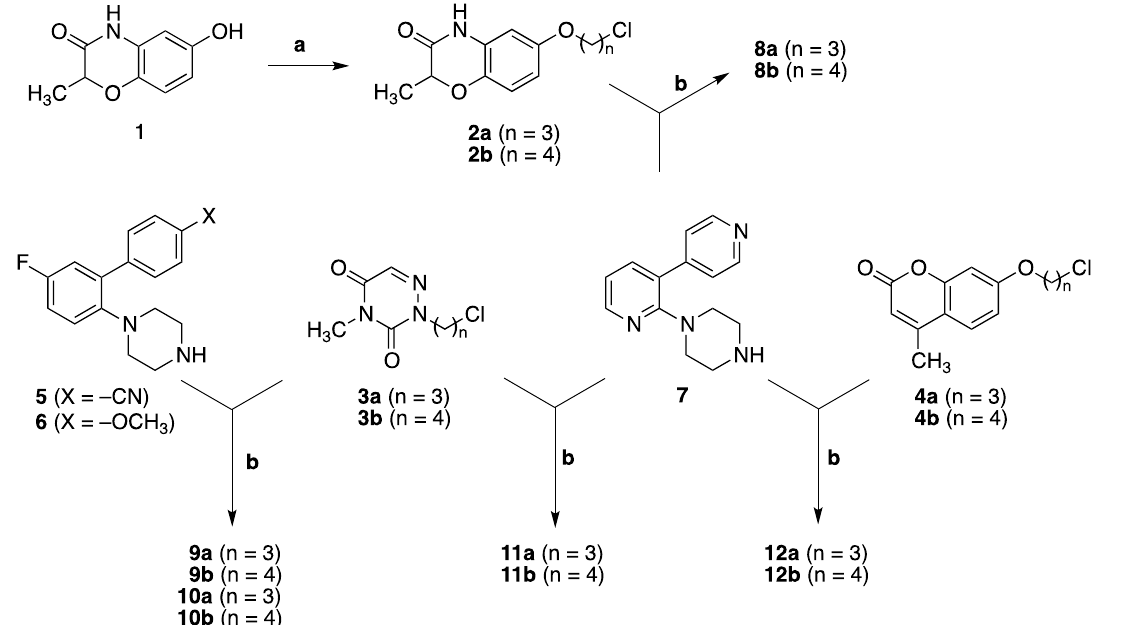
Table 2. Affinity and Cytotoxicity Data of the Target